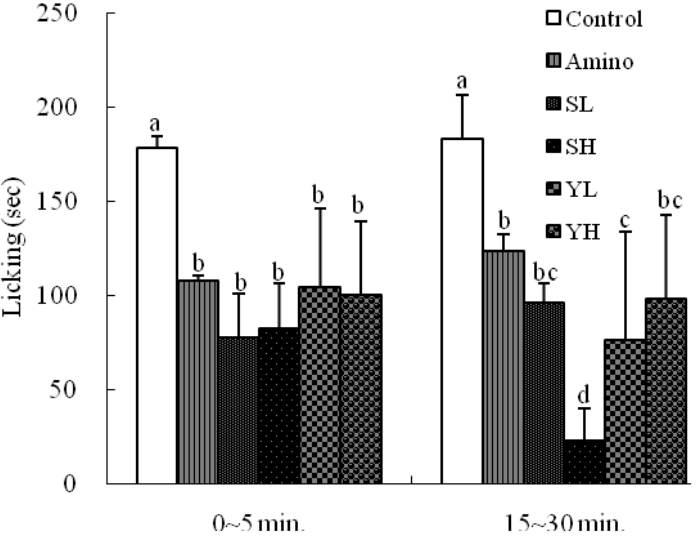
Figure 3. Effects of SoRiTae and Yak-Kong ethanolic seed extracts on formalin-induced paw licking in mice. Amino: Aminopyrine (50 mg/kg); SL: SoRiTae (100 mg/kg); SH: SoRiTae (200 mg/kg), YL: Yak-Kong (100 mg/kg), YH: Yak-Kong (200 mg/kg). Each values was expressed as the mean ±S.E.M. (n = 6). a-d Means in the same column not sharing a common letter are significantly different (p < 0.05) by Duncan's multiple